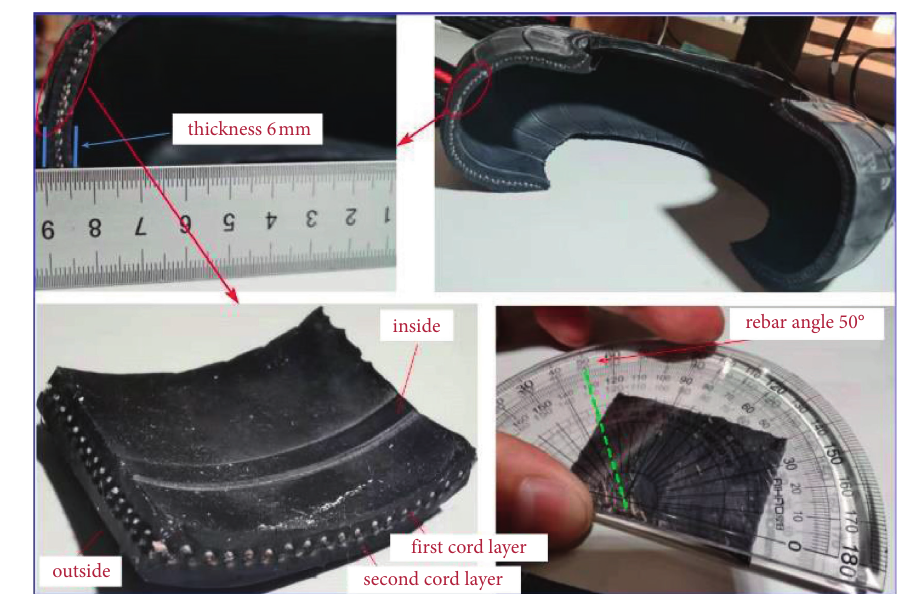
Figure 6: Cord distribution of the airbag rubber matrix.